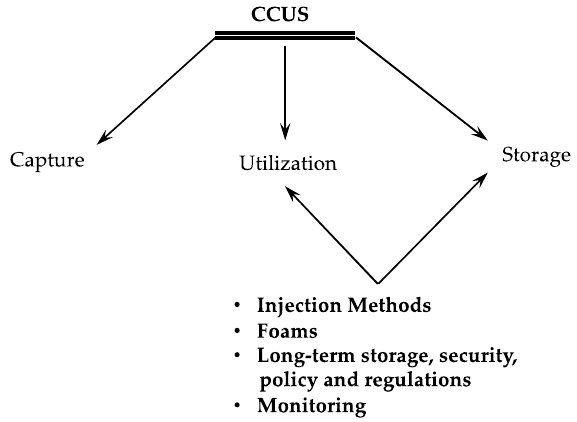
Figure 1. Scope of the paper.